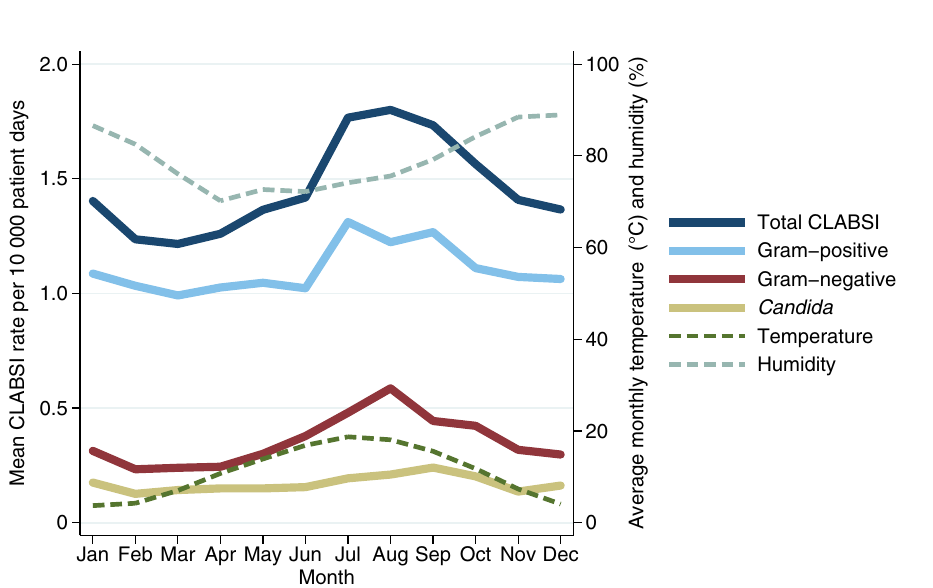
Figure 1. Seasonal variation of hospital-wide central line-associated bloodstream infection incidence, per microorganism. Composite monthly incidence rates of central line-associated bloodstream infection (CLABSI) based on the hospital-wide mixed-effects regression analysis results (Table 3). Total CLABSI seasonality during July–August was associated with both gram-positive and gram-negative increases. The rate of total CLABSI classifies polymicrobial BSI as a single